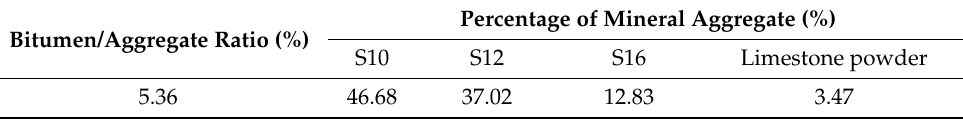
Figure 3. Gradation design of porous asphalt mixture based on Bailey method. Table 9. Mineral aggregate composition of gradation scheme.